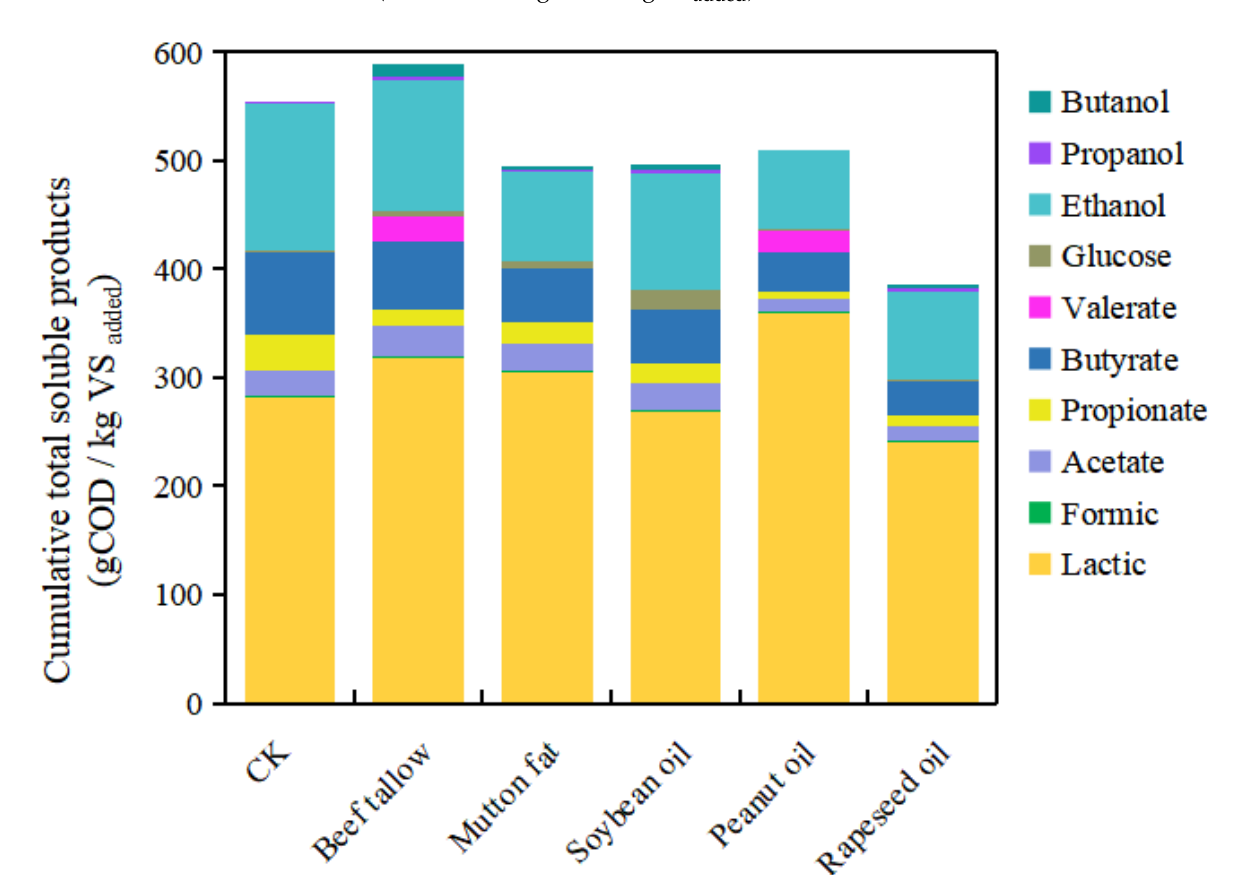
Figure 5. Cumulative soluble product production in different treatments. CK — blank, T1 — beef tal- low, T2 — mutton fat, T3 — soybean oil, T4 — peanut oil, T5 — rapeseed oil